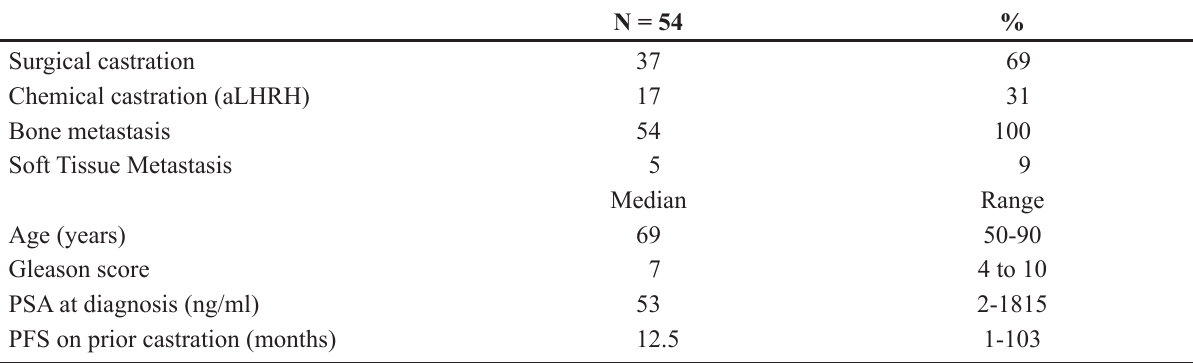
Table 1 – Patients’ characteristics.